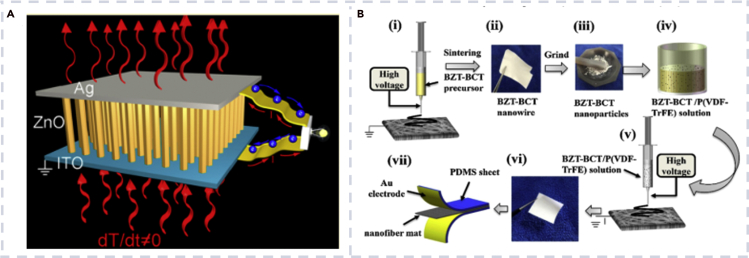
Biocompatible nanogenerator based on different inorganics(A) The structure of a pyroelectric nanogenerator (Yang et al., 2012a).(B) Fabrication process of a BZT-BCT/P(VDF-TrFE)-based nanogenerator (Liu et al., 2020).